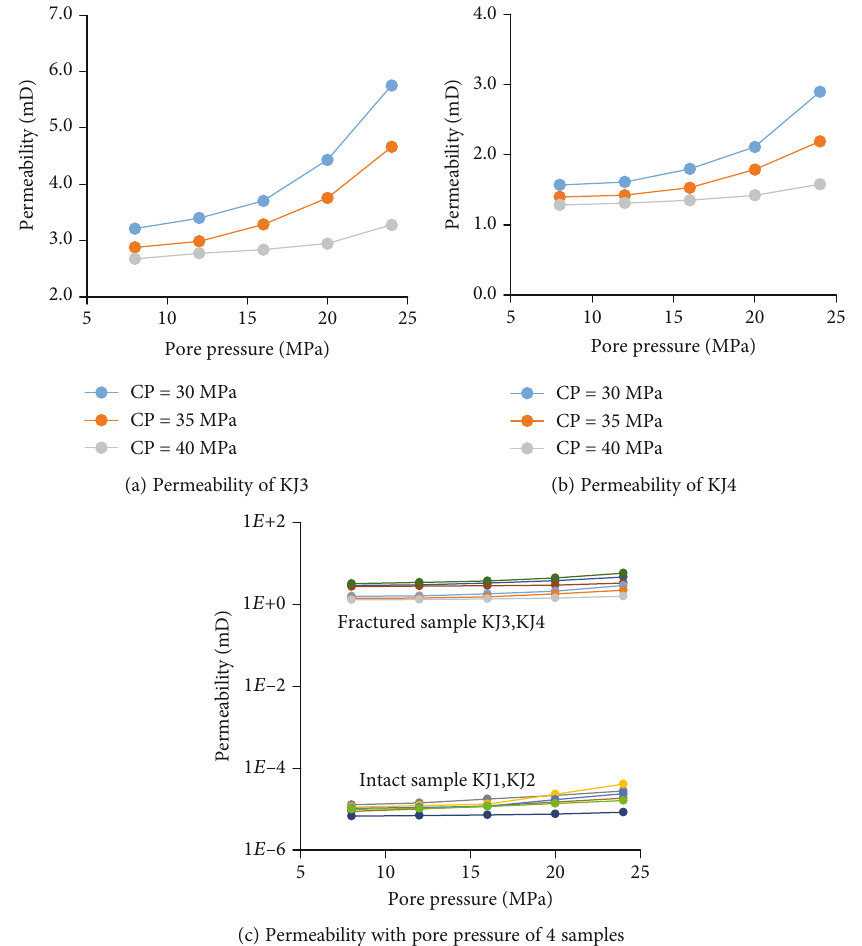
Figure 7: Relationship between permeability and pore